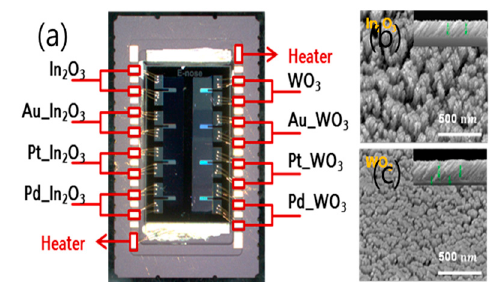
Figure 1. Sensor Array fabricated by KIST.